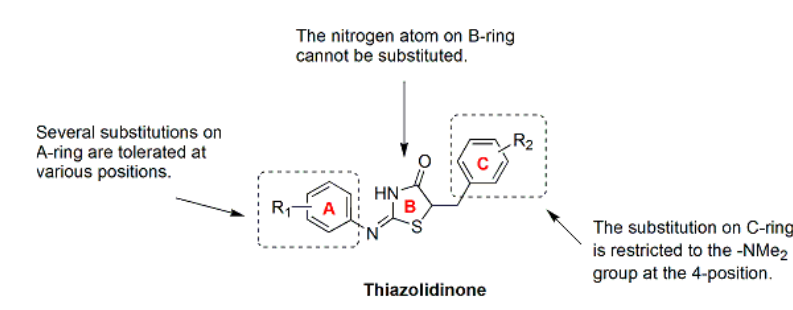
Figure 12. SAR of Thiazolidinone [128].